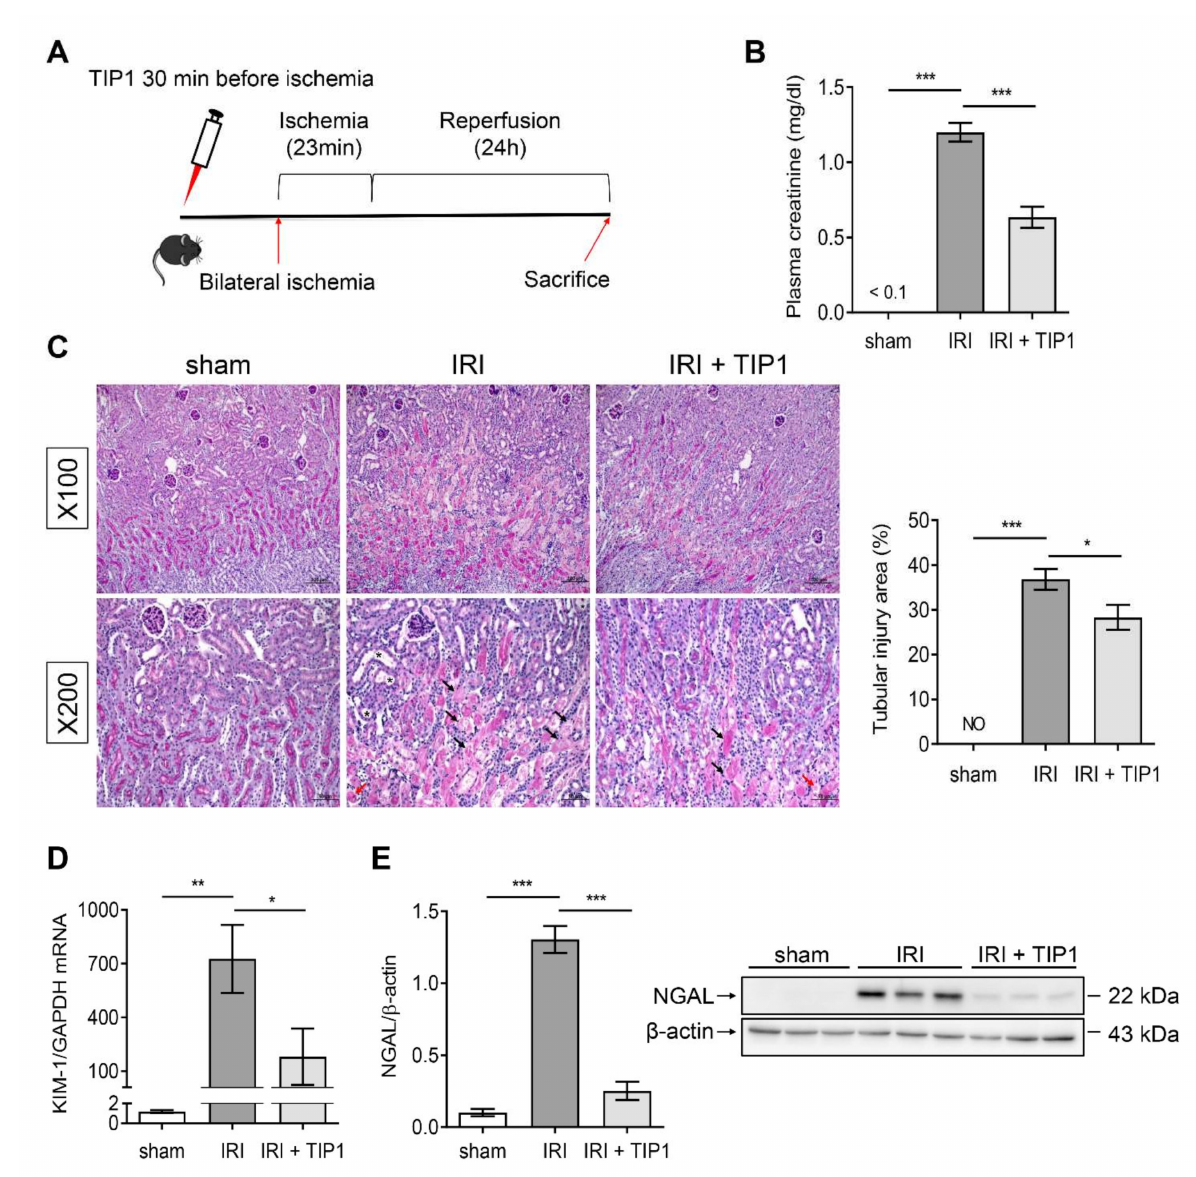
Figure 2. TLR-inhibitory peptide 1 (TIP1) attenuates kidney ischemia-reperfusion injury (IRI). ( A ) Experimental design. ( B ) Plasma creatinine levels. ( C ) The percentage of injured tubules in the deep cortex and the corticomedullary junction was assessed on periodic acid–Schiff staining. The lower images show higher magnification of the upper images. Black arrows indicate necrotic tubules with loss of brush border and red arrows indicate tubular casts. Asterisks represent dilated tubules. Scale bar = 100 (upper images) and 50 (lower images) µ m. ( D ) KIM-1 mRNA expression in the kidney tissue. ( E ) Western blot analysis of NGAL in the kidney tissue. Sham ( n = 6), IRI ( n = 6), and IRI-TIP1 ( n = 6). β -actin from the same membrane was used for densitometry. Data are expressed as mean ± SEM. * p < 0.05, ** p < 0.01, *** p < 0.001. Not observed